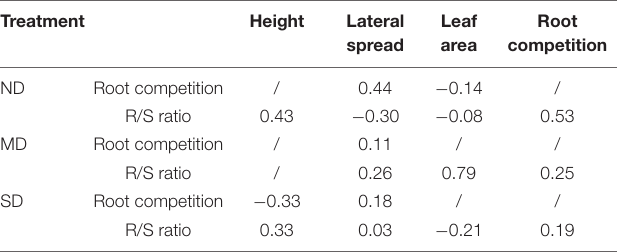
TABLE 3 | Standardized total effects of plant height, lateral spread, leaf area, and root competition on R/S ratio in different degradation gradients in an alpine meadow in the eastern Qinghai-Tibetan